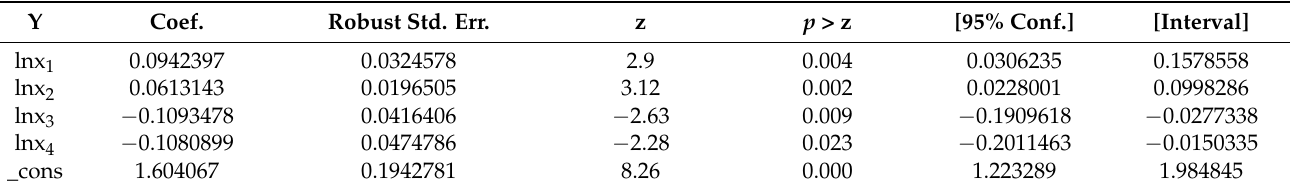
Table 8. Parameter estimation results of Fractional Logit model. Y